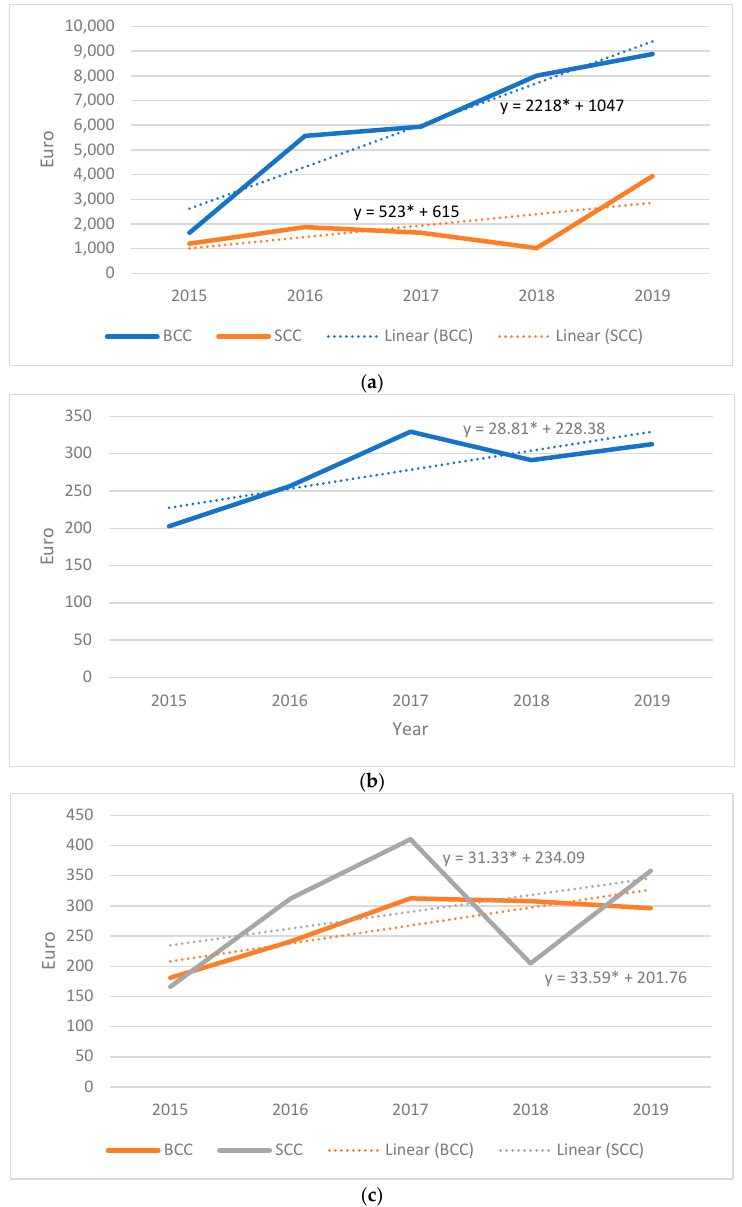
Figure 7. Direct treatment costs of NMSC: ( a ) total costs/5 years for SCC and BCC; ( b ) the increasing NMSC treatment costs/episode during 5 years of analysis; ( c ) the increasing BCC and SCC treatment costs/episode during 5 years of analysis.